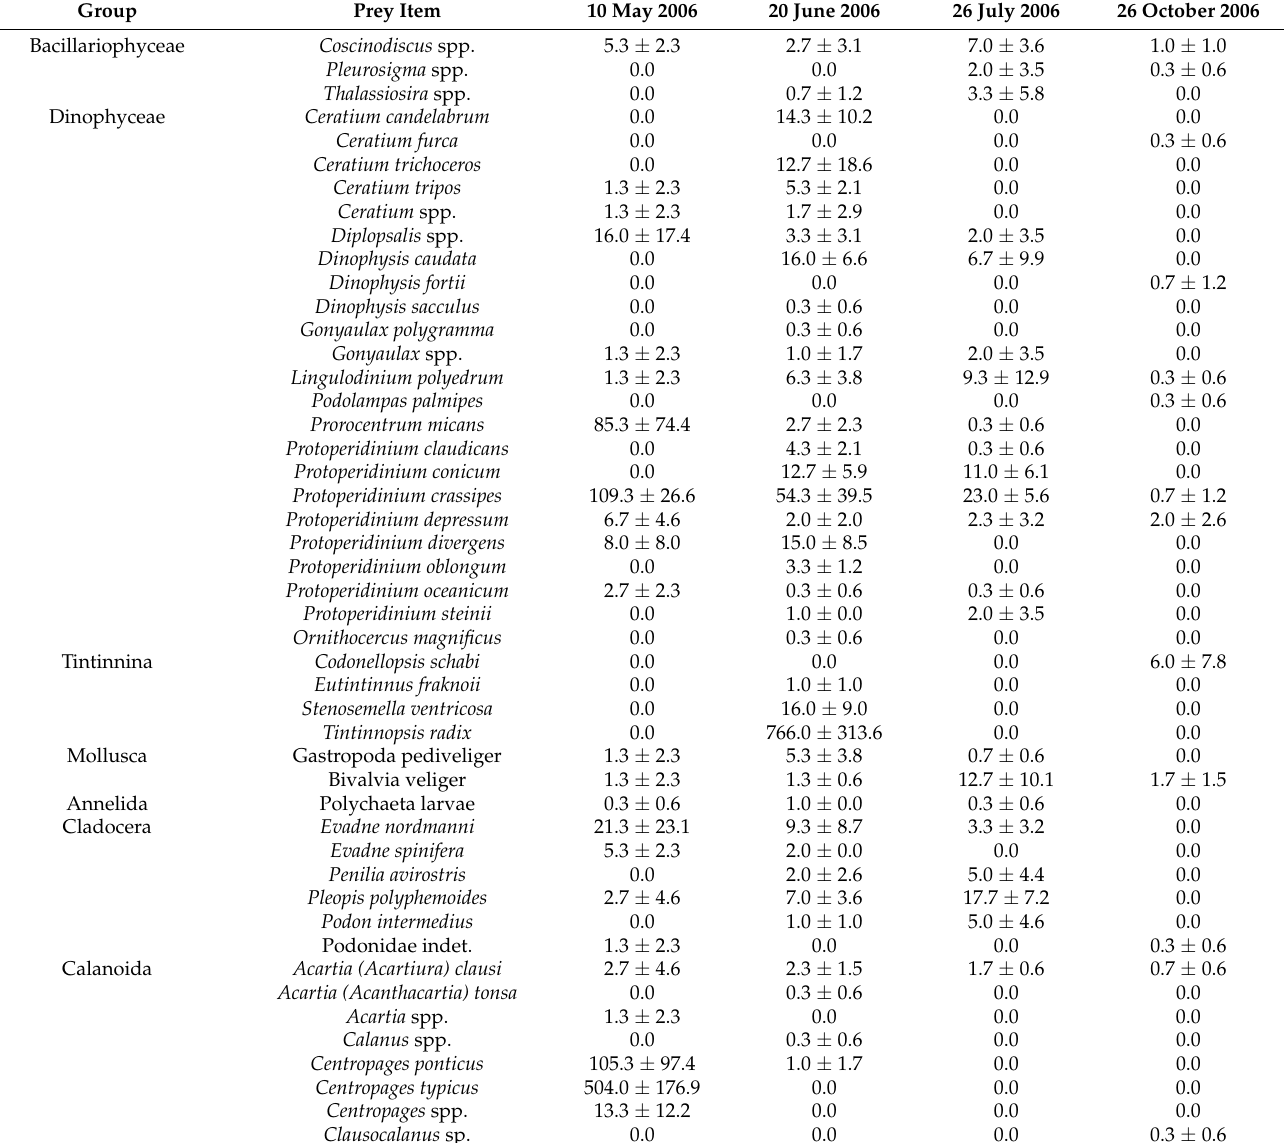
Table 3. Taxonomic composition of identifiable stomach contents expressed as mean ± st. dev. of prey